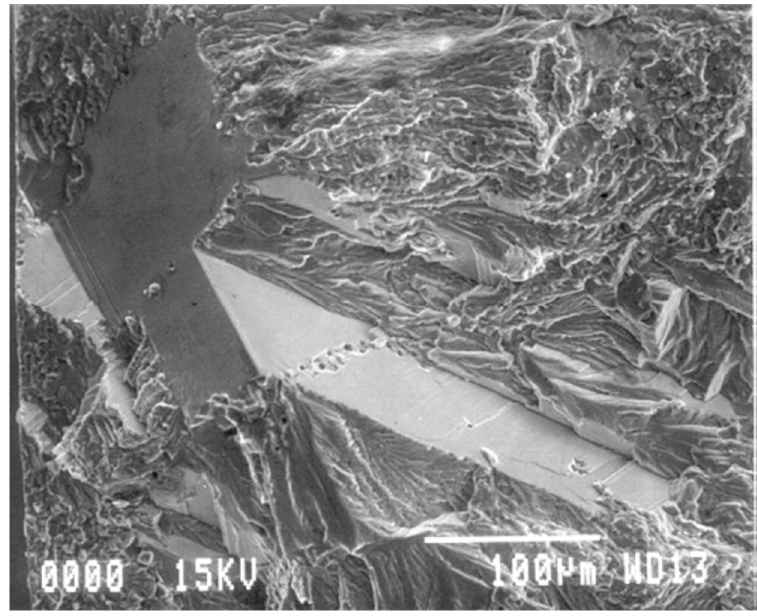
Figure 11. Fatigue fracture of Al–7Si–0.4Mg alloy showing especially perfect facets [35].